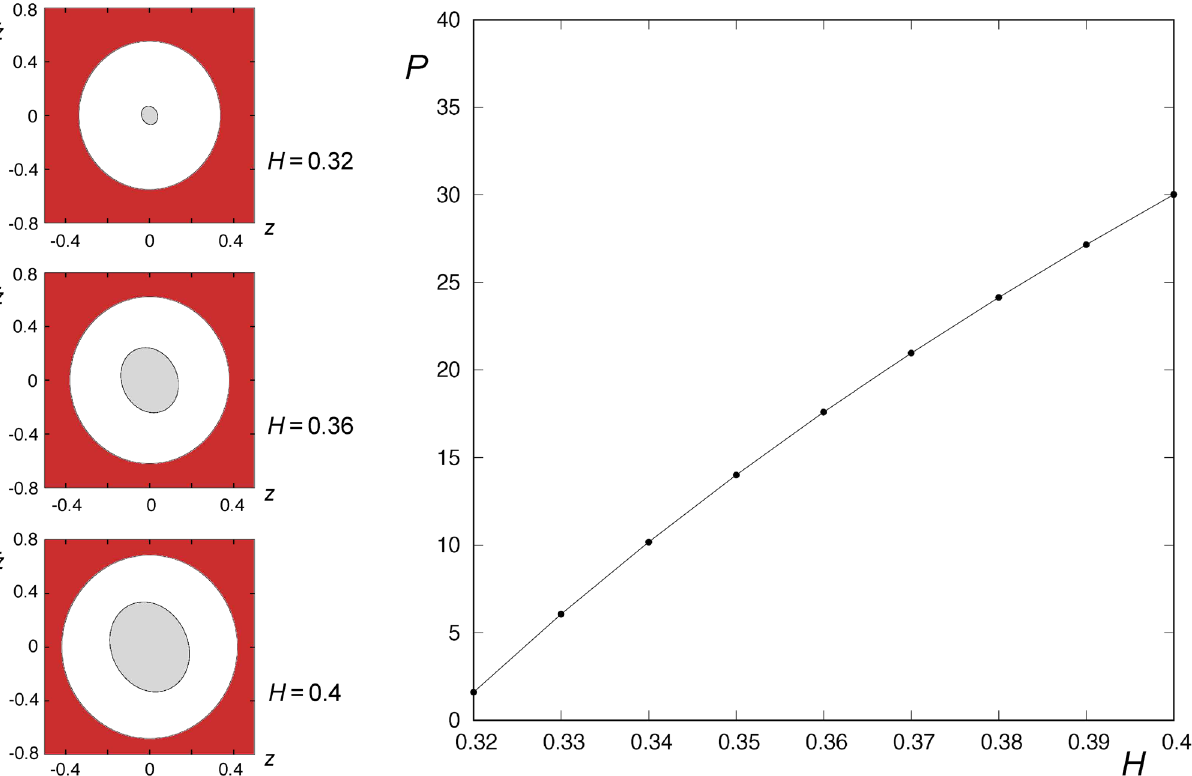
Figure 9. In the right panel, percentage of area that the region enclosed by W s ,1 (φ) occupies in the domain bounded by the limit curve (6), for values of the energy given by H = H 0 + n (cid:31) , where H 0 = 0.32 , (cid:31) H = 0.01 and 0 ≤ n ≤ 8 . In the three panels in the left, we represent W s ,1 (φ) together with the limit curve, for H = 0.32, 0.36 and 0.4 (from the top to the bottom, respectively). The initial conditions of orbits colored in grey correspond to orbits that escape directly from the potential well. We have marked the set of initial conditions outside the limit curve, and prohibited by the value of energy, in red color. This graphic has been generated by using Gnuplot Version 5.2. http:// www. gnupl ot.